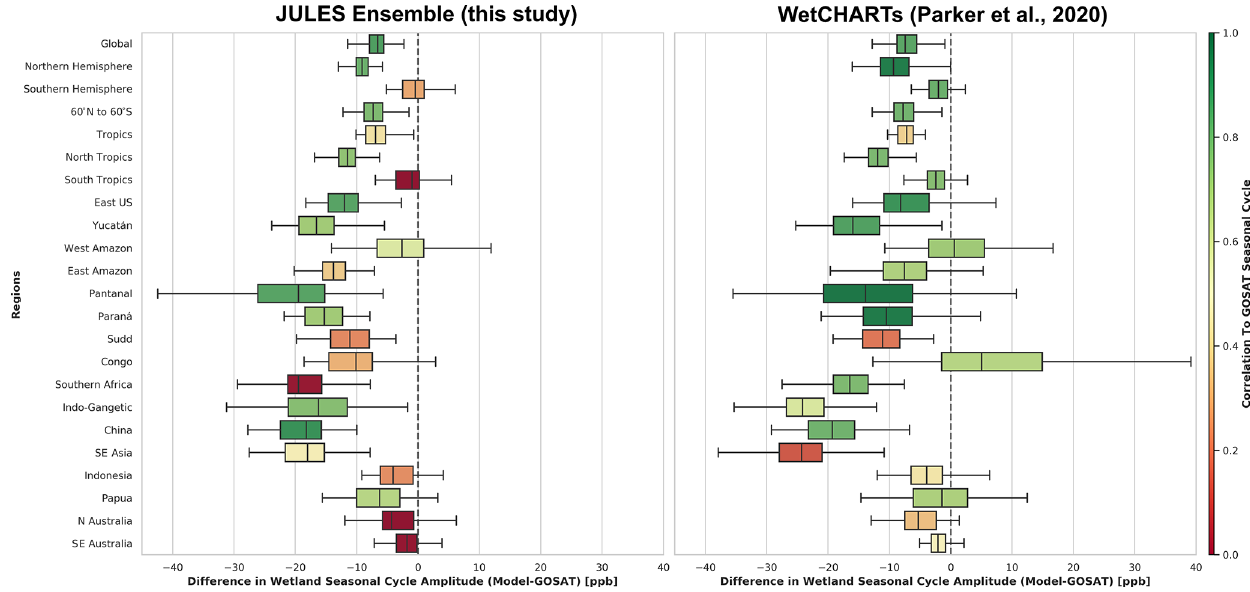
Figure A1. Comparison of Fig. 5 from this study for JULES against Fig. 4 from Parker et al. (2020b) for WetCHARTs. Figure A2 shows the correlation coefficient between the different ensemble members and the observed wetland CH 4 seasonal cycle for the Sudd region. The majority of the en- semble members correlate strongly to each other ( r > 0 . 9) but poorly to the observed seasonal cycle ( r < 0 . 2). The set